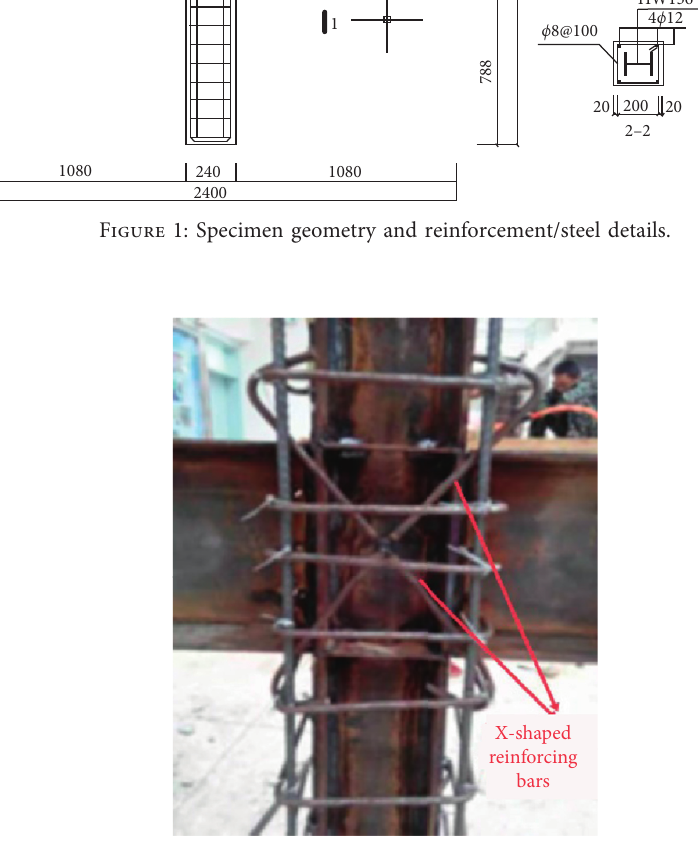
Figure 2: Details of X-shaped reinforcing bars and